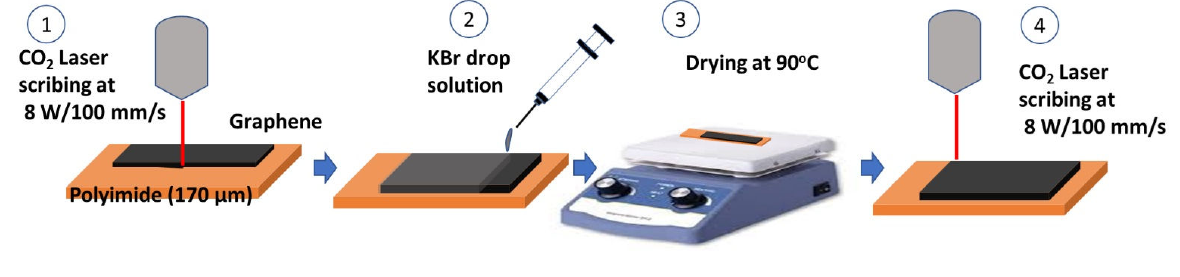
Figure 1. The scheme shows the steps for preparing LIG and K-LIG composite by using a CO 2 laser